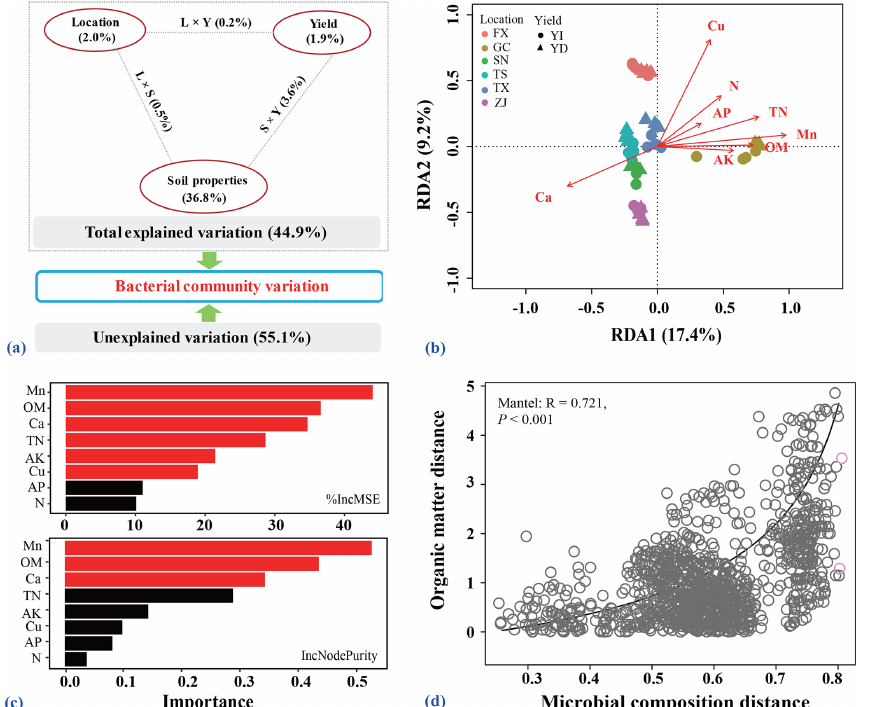
Figure 6. Relationships among bacterial communities, soil edaphic factors and pear yield. (a) Variance partitioning analysis (VPA) map of the effects of soil edaphic properties, sample locations, pear yield and interactions of these factors on the bacterial communities. (b) Redundancy analysis (RDA) plot showing the relationships among all assigned bacterial ASVs and measured soil edaphic properties for all soils after stepwise selection. (c) Random forest mean predictor importance of selected soil edaphic properties used as drivers in predicting the pear yield. Red bar indicates that the given predictor is significant, while black bar indicates that the given predictor is non-significant. The %IncMSE in the upper panel means the increase in mean squared error, while IncNodePurity indicates the increase in node purity. The values of these two indices represent the importance of each variable to predict the module. A larger value indicates that the variable is more important. (d) Correlation plot showing the relationship of microbial composition and soil organic matter based on Bray–Curtis distances calculated by the Mantel